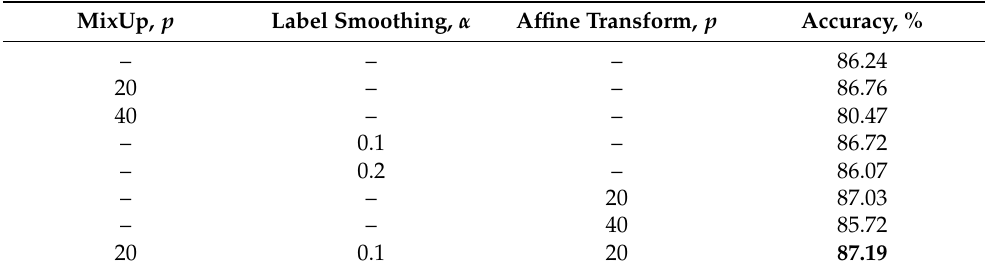
Table 5. Accuracy results of applying video data augmentation techniques: p is the probability (in %) of the maximum number of images to be augmented; α —the smoothing coefficient of the vector.